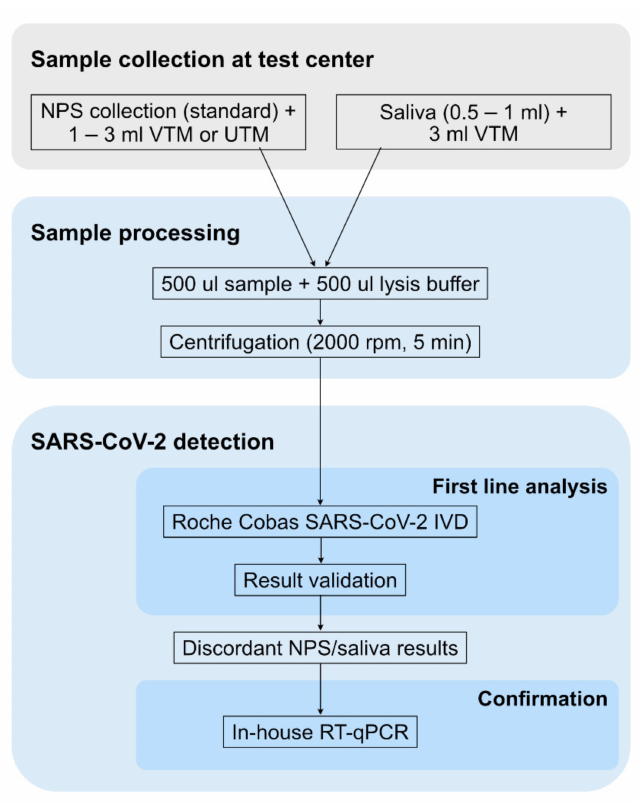
Figure A2. Flowchart of the sample analysis